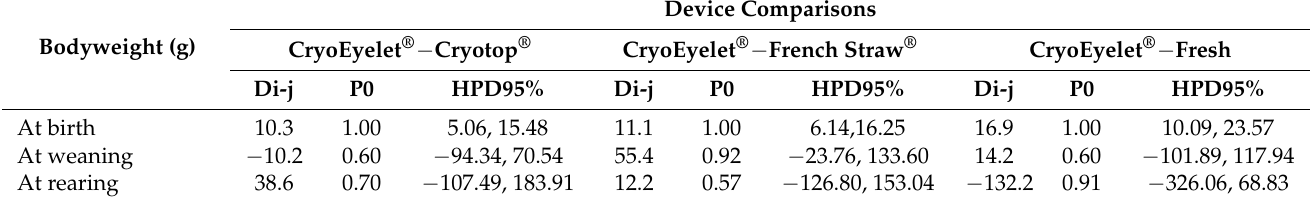
Table 3. Bodyweight progenies differences using CryoEyelet ® , Cryotop ® , and French Straw ® devices and fresh control group. Data computed as CryoEyelet ® − Cryotop ® , CryoEyelet ® − Straw ® and CryoEyelet ® −